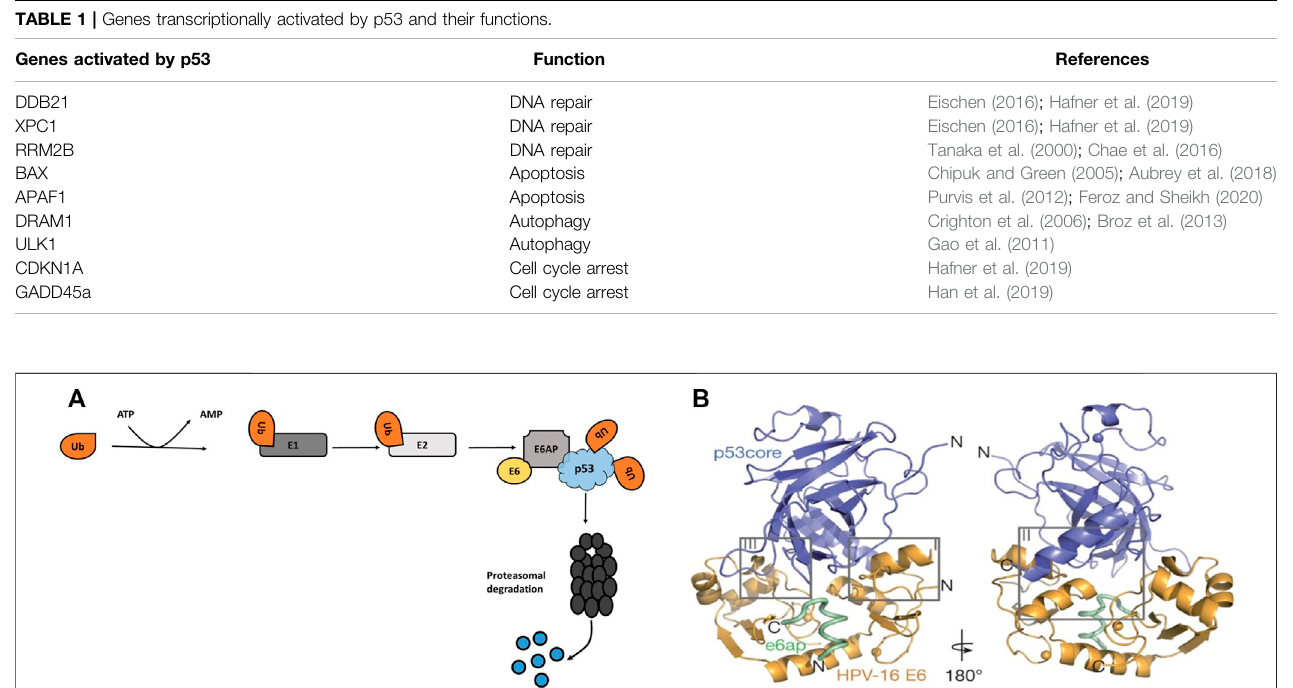
FIGURE 4 | (A) HPV oncoprotein E6 induces p53 proteasome degradation through E6AP. A cascade of ubiquitination occurs when E1 protein activate ubiquitin, which allows E2 conjugating enzymes to transfer the ubiquitin to E6AP, a ubiquitin-protein ligase. (B) Structural interaction between the HPV-16 E6, E6AP and p53 protein (Martinez-Zapien et al., 2016). E6 interact with p53 by binding to the LxxLL motif of E6AP, the LxxLL motif is suf fi cient to render E6 able to promote p53 degradation.